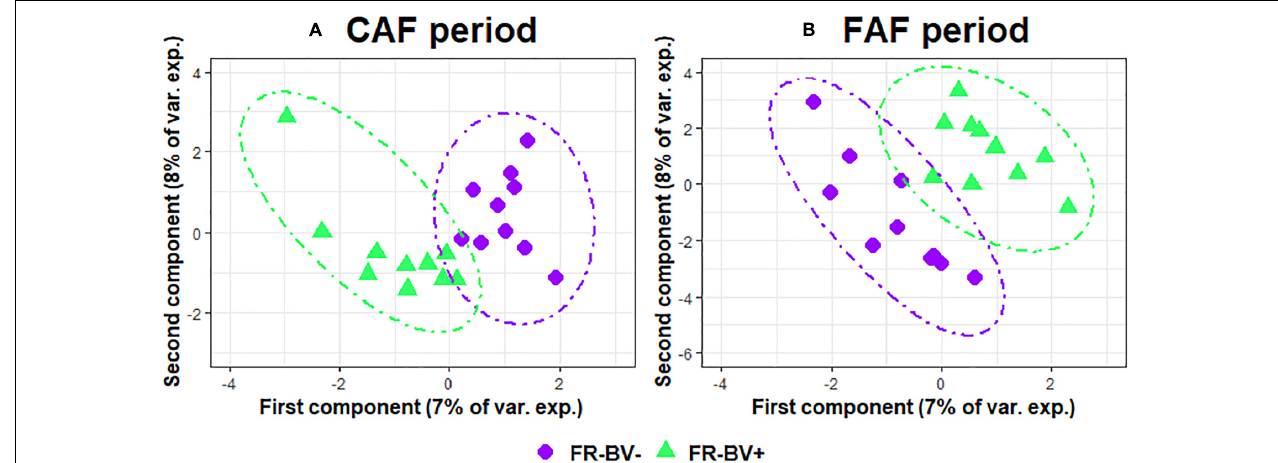
FIGURE 6 | Sparse partial least squares discriminant analysis of ruminal bacteria abundances at the genus level according to feeding rate index groups ( N = 20) during 100% concentrate CAF ( A - sPLS-DA with 2 components, 4 and 6 variables per component and a BER of 0.40) and 67% forage FAF ( B - sPLS-DA with 1 component and 3 variables, and a BER of 0.45)